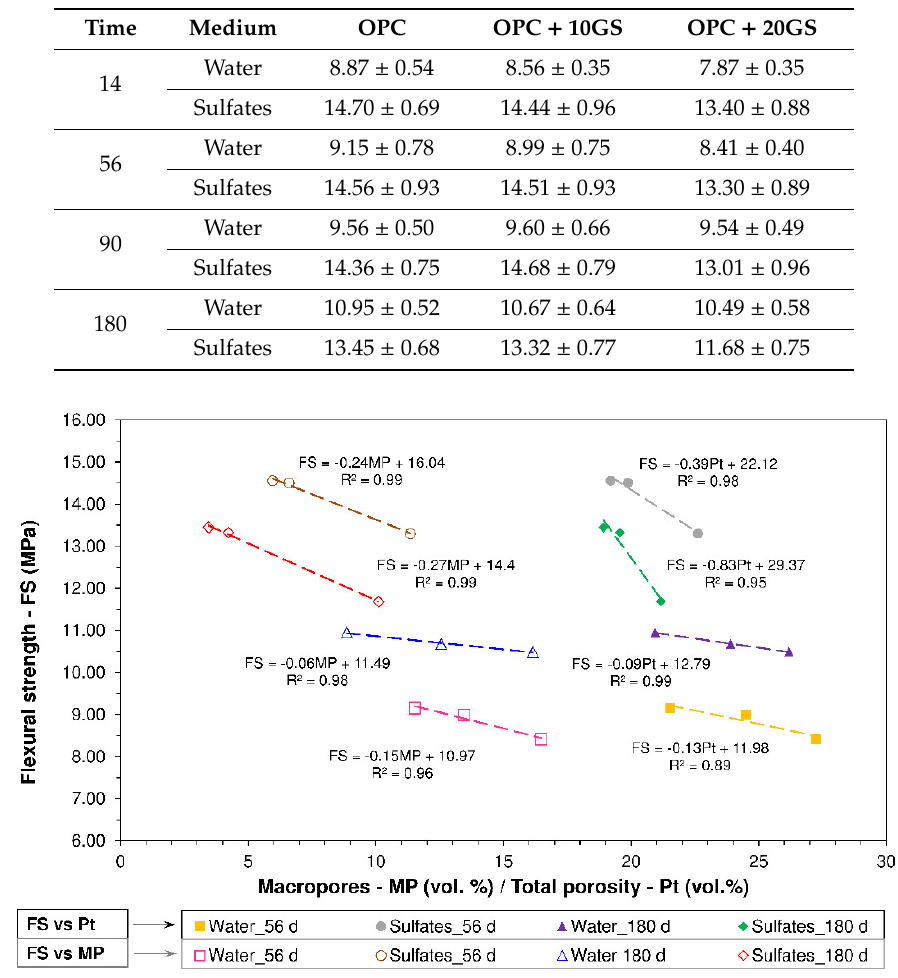
Figure 5. Flexural strength vs. pore system properties.